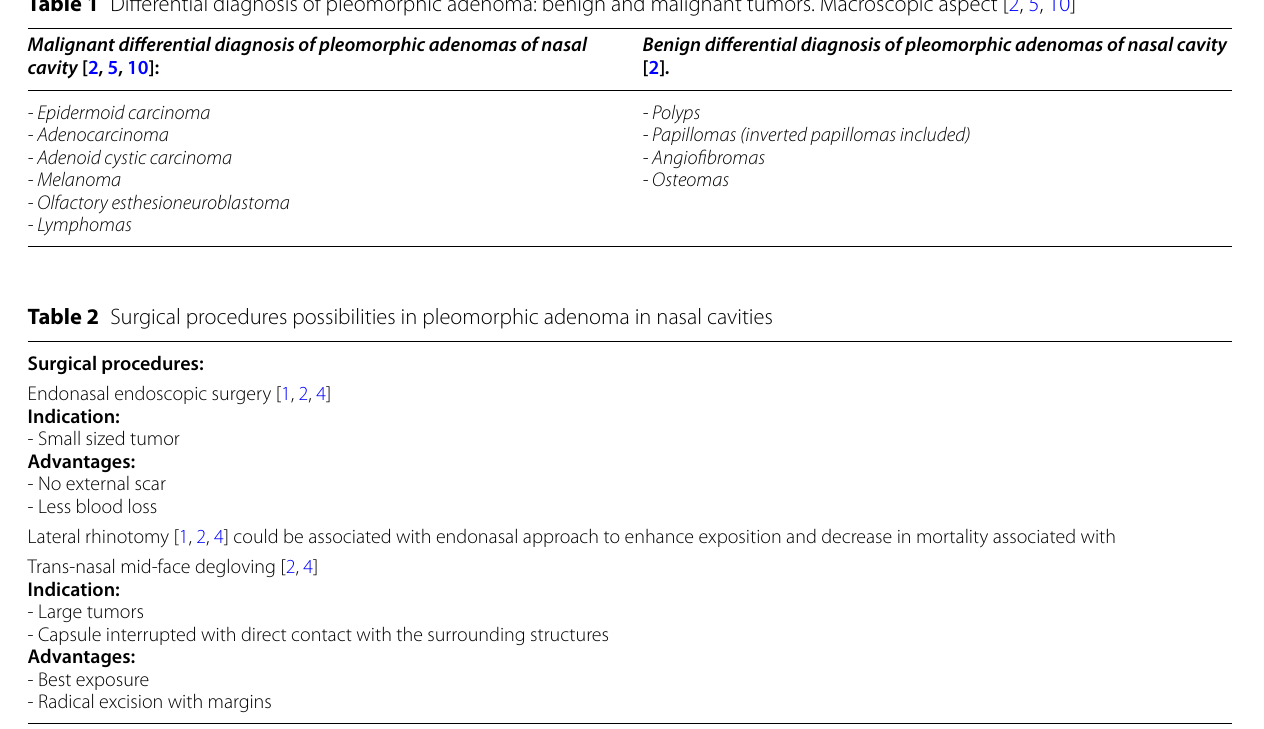
Benign differential diagnosis of pleomorphic adenomas of nasal cavity [2] .